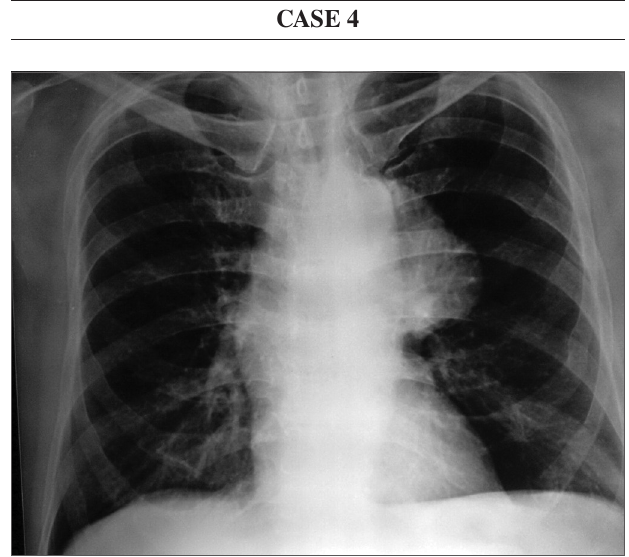
Figure 1. Chest X-ray PA view showing well- defined lobulated medias- tinal lesion on the left side. A 55-year old male patient presented with